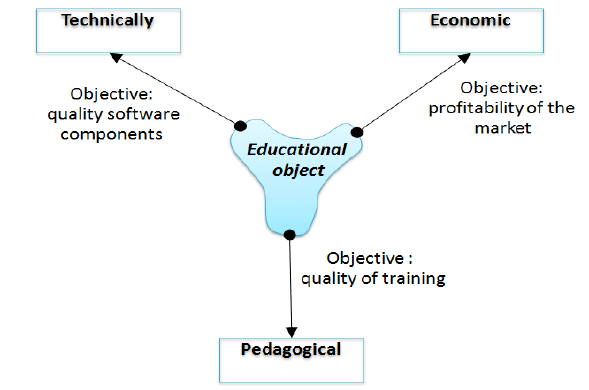
Figure 1. A concept from different points of view